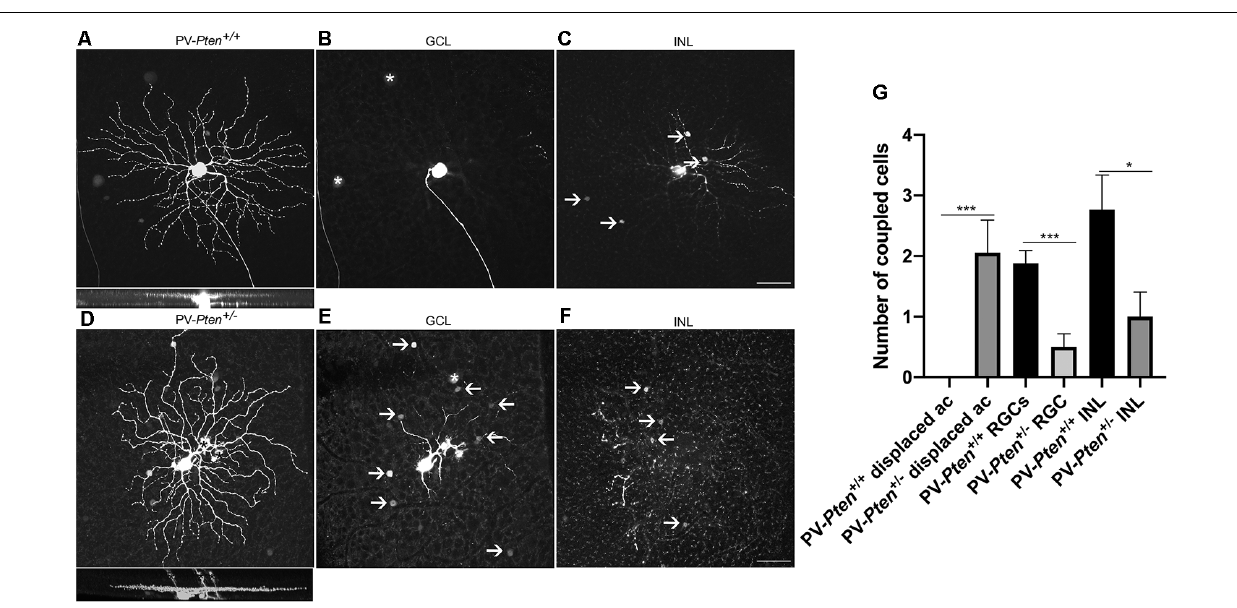
FIGURE 7 | Tracer coupling of OFF α -RGCs in PV- Pten +/+ and PV- Pten + / − retinas. (A) Neurobiotin-filled OFF α -RGC in PV- Pten +/+ retina and its stratification pattern. (B) OFF α -RGC shows tracer-coupling to neighboring RGCs in the GCL (asterisk) in PV- Pten +/+ retina. (C) OFF α -RGC shows tracer-coupling to amacrine cells in the INL (arrows) in PV- Pten +/+ retina. (D) Neurobiotin-filled OFF α -RGC in a PV- Pten + / − retina and its stratification pattern. Asterisks show mis-injected Müller cells. (E) OFF α -RGCs show tracer-coupling to ganglion cells (asterisks) and displaced amacrine cells (arrows) in the GCL in PV- Pten + / − retina. (F) OFF α -RGC shows tracer-coupling to amacrine cells in the INL (arrows) in PV- Pten + / − retina. (G) Histogram indicating the mean ( ± SEM) number of cells coupled to OFF α -RGCs ( n = 17 cells from PV- Pten +/+ mice, n = 18 cells from PV- Pten + / − mice, * P < 0.05, *** P < 0.001, Mann-Whitney test). z-step = 0.3 µ m. 75–90 optical sections were compressed for viewing. Scale bar = 50 µ